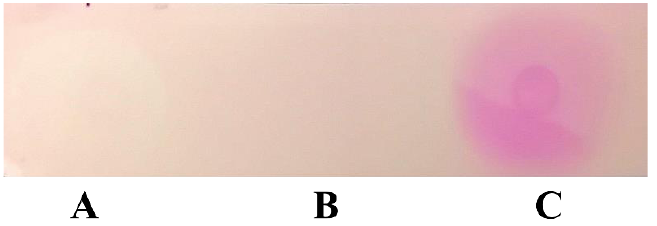
Figure 7. Result of the qualitative reaction to glycoproteins: bovine serum albumin ( A ); Aspergillus clavatus VKPM F-1593 extracellular keratinase ( B ); invertase ( C ).